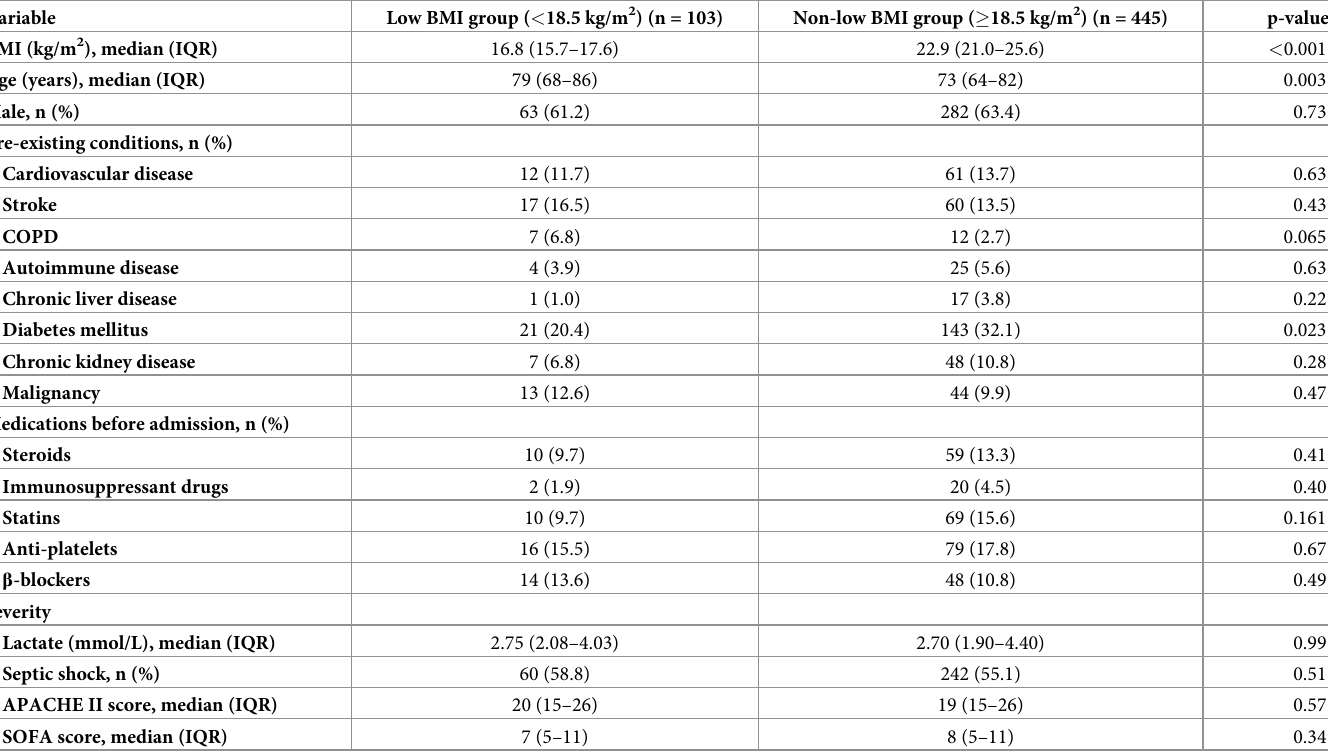
Table 2. Patient demographics and clinical data of the low and non-low BMI groups.